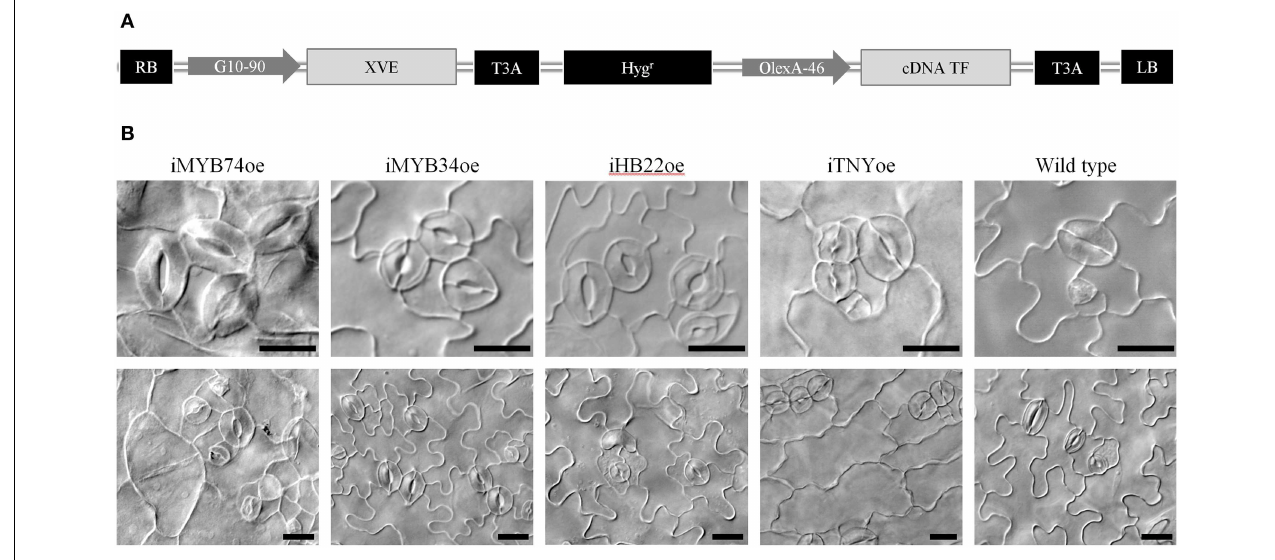
XVE. cDNA TF: coding sequence for the different transcription factors. T3A: sequence for gateway cloning. For more details, see Coego et al. (2014). (B) Phenotypic effects of overexpression for selected TF. DIC micrographs of cotyledon abaxial epidermis in seedlings of the indicated genotypes (iTFoe and wild-type) grown for 6 days in β -estradiol plates. For each genotype, two representative fields are shown. Bar, 20 µ m.